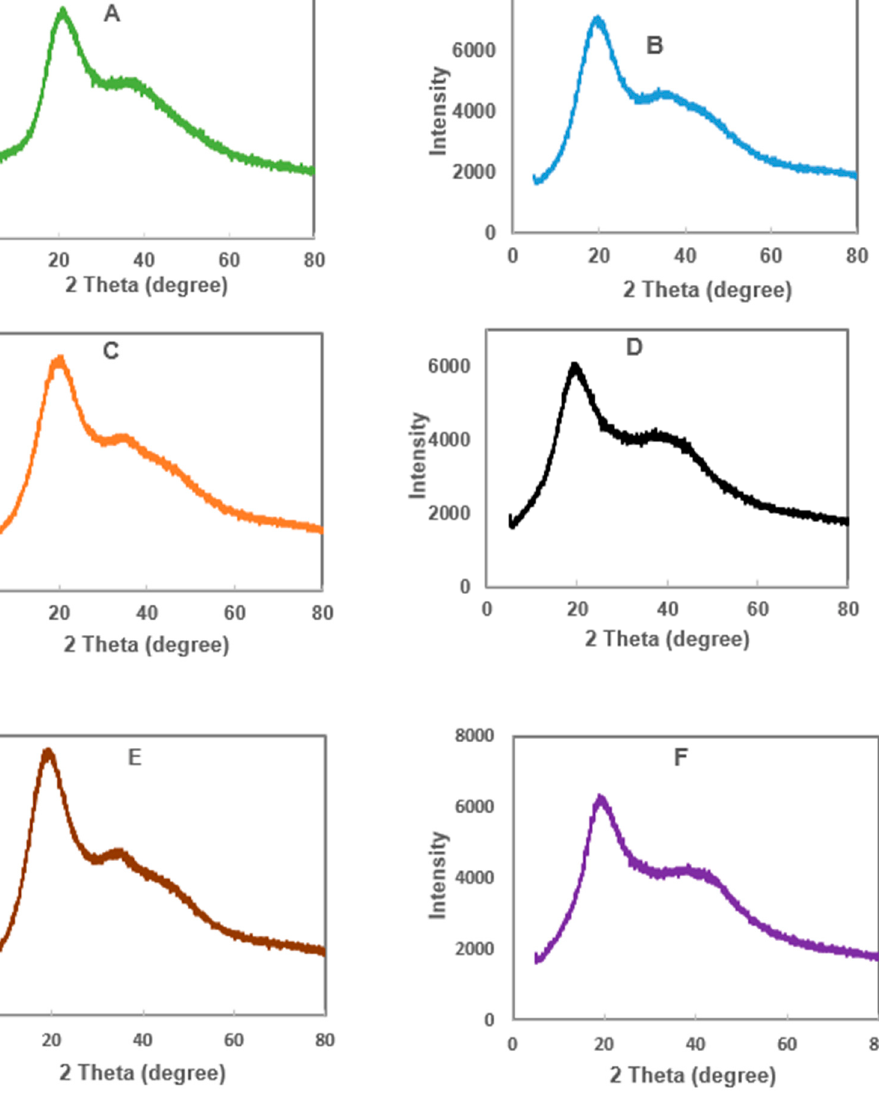
Figure 3. X-ray diffractogram of ( A ) M. oleifera extract ( B ) M. oleifera microcapsules in MDGA ( C ) M. oleifera microcapsule in MD ( D ) M. oleifera microcapsule in GA ( E ) MD ( F ) GA coatings.